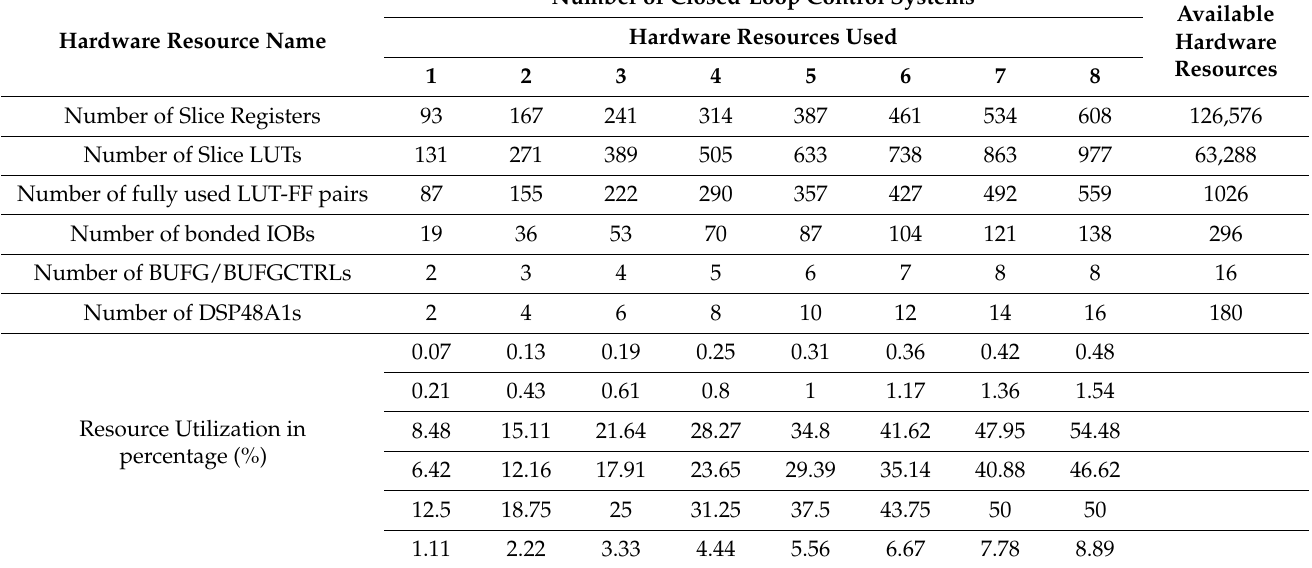
Table 2. Utilization of FPGA hardware resources for different numbers of closed-loop control systems using XC6SLX100T-4-CSG484 (SPARTAN6).